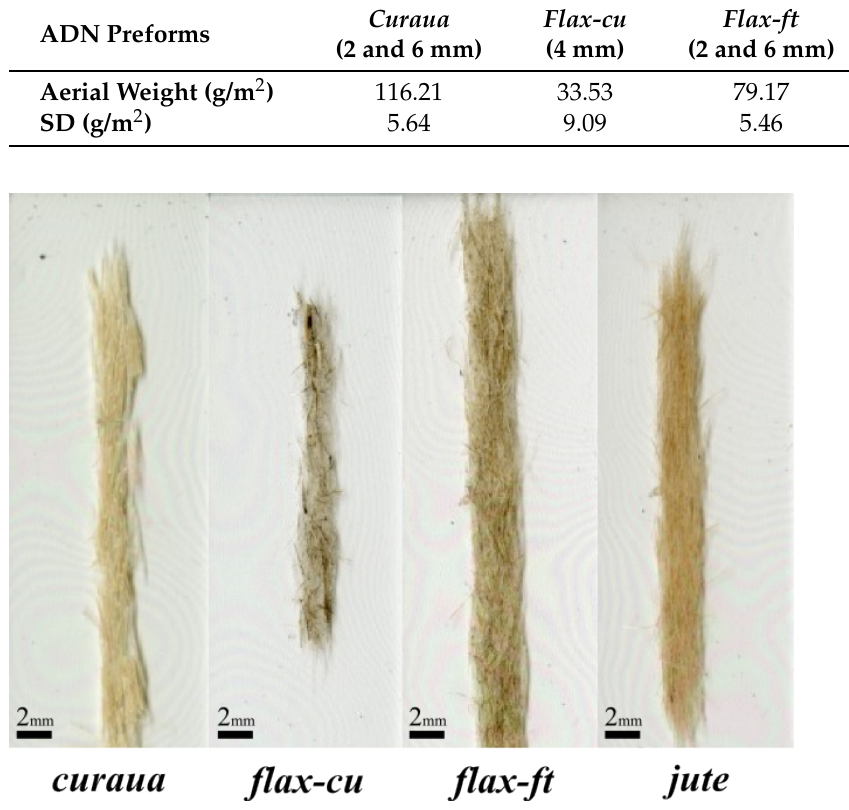
Figure 6. Top view of ADN